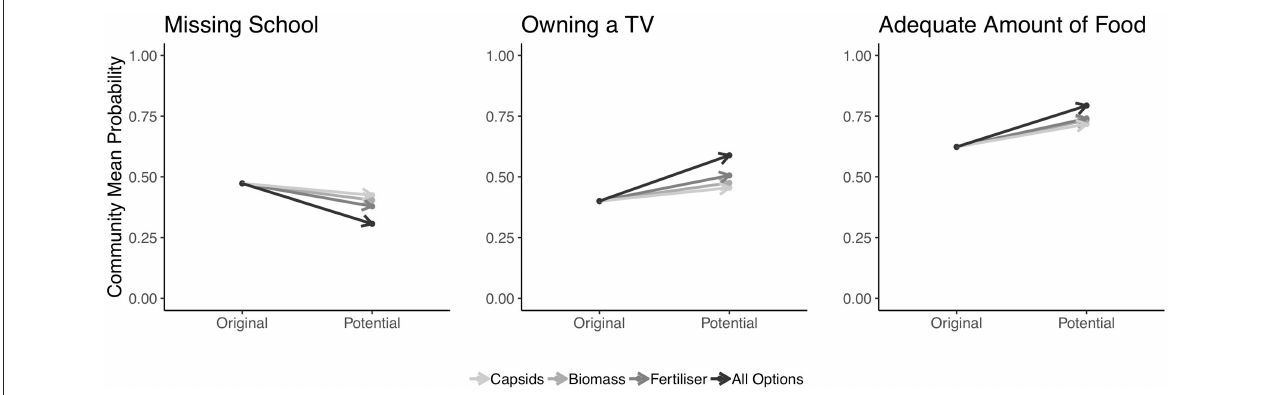
FIGURE 5 | Community Changes in Poverty Indices. Paired data plots showing changes in household poverty measures, averaged over the community, based on “original” conditions compared with changes expected if cocoa yields and incomes were improved for each factor separately and all